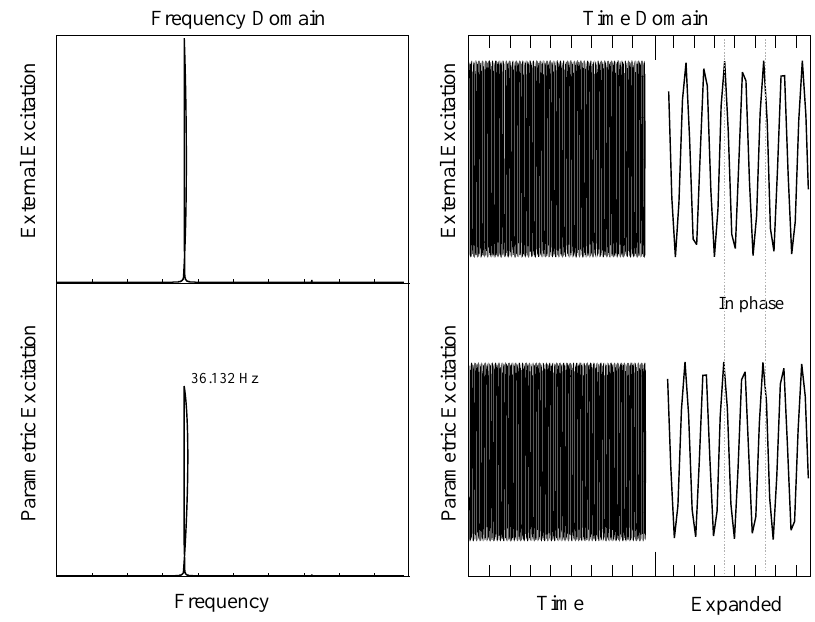
Fig. 13. Experimental frequency and time domains representation of the excitations, for the case of they are in phase